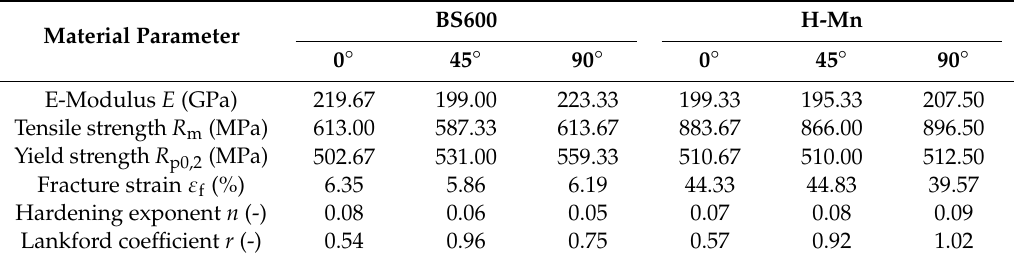
Table 1. Material parameters of BS600 and high-manganese (H-Mn) steel in t 0 = 2 mm determined by tensile tests.